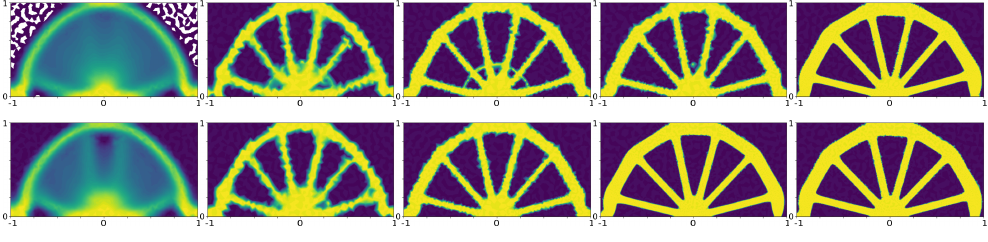
Figure A7. Optimisation without and with N CNN . Sequence ϕ 100 , ϕ 200 , ϕ 300 , ϕ 400 , ϕ 538 from Algorithm A1 ( top row ). Sequence ϕ 100 , ϕ 200 , ϕ 300 , ϕ 400 , ϕ 441 from Algorithm 1 ( bottom row